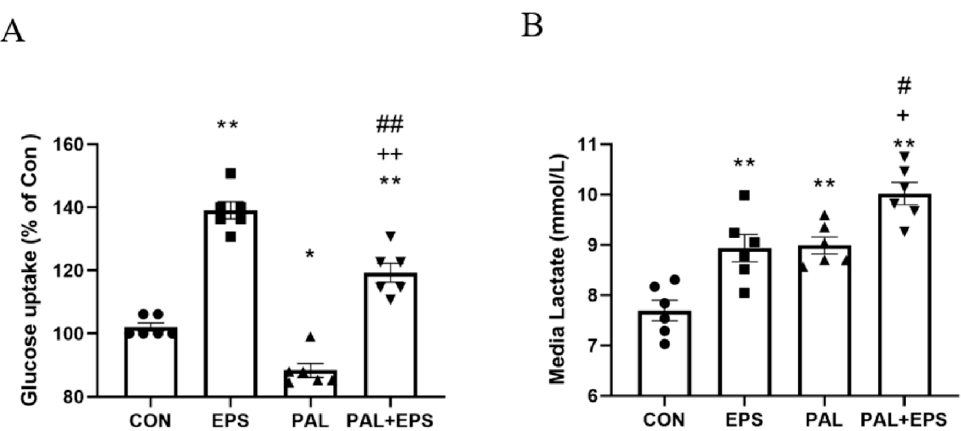
Figure 2. C2C12 myotube glucose uptake ( A ) and cell media lactate concentration ( B ) after exposure to either standard growth media (CON), 16 h of electrical pulse stimulation (EPS; 11.5 V, 1 Hz, 2 ms), 300 μ M palmitate (PAL) or the combination of both palmitate and EPS (PAL + EPS). Significantly different from control (CON, * p < 0.05, ** p < 0.01). Significantly different from palmitate (PAL; # p <